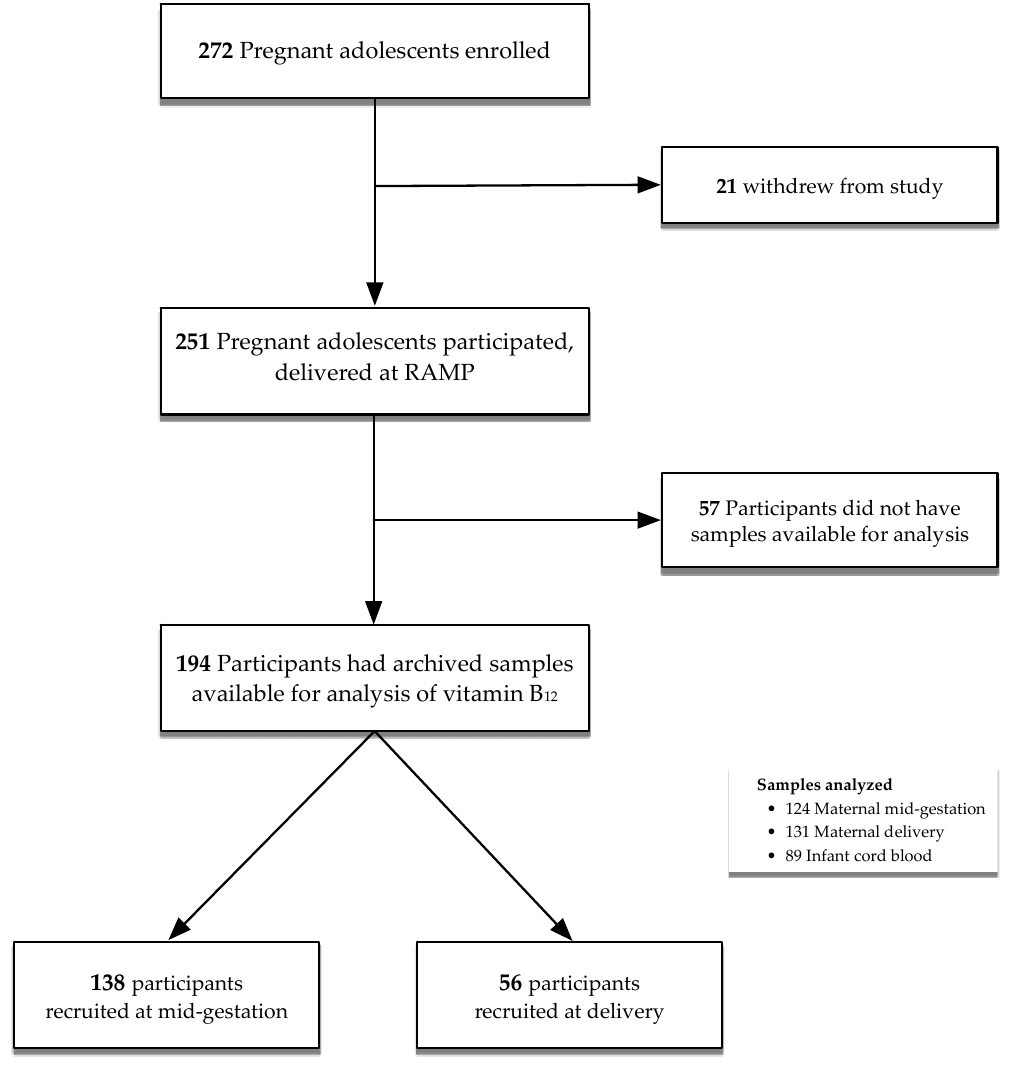
Figure 1. Participant flow diagram.